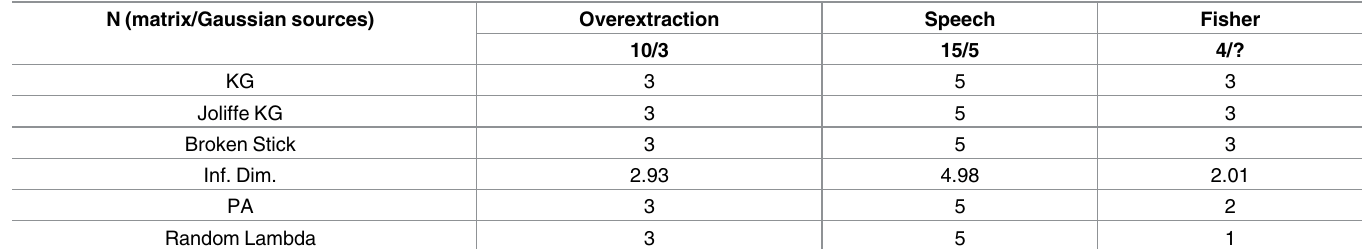
Table 2. Results for estimated dimension of Gaussian subspaces.